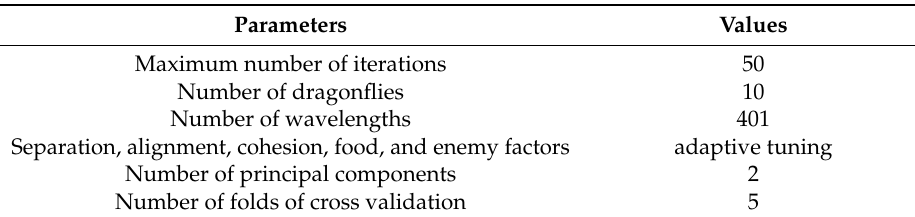
Table 2. Values of the BDA parameters.